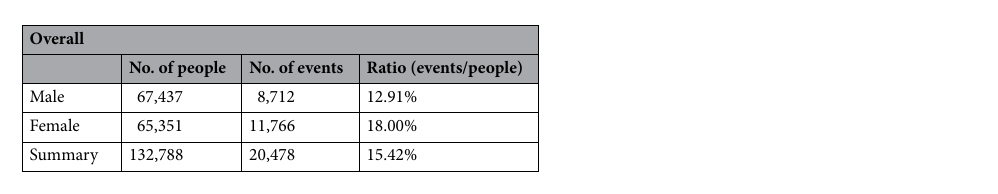
Table 1. Distribution of people within analysed